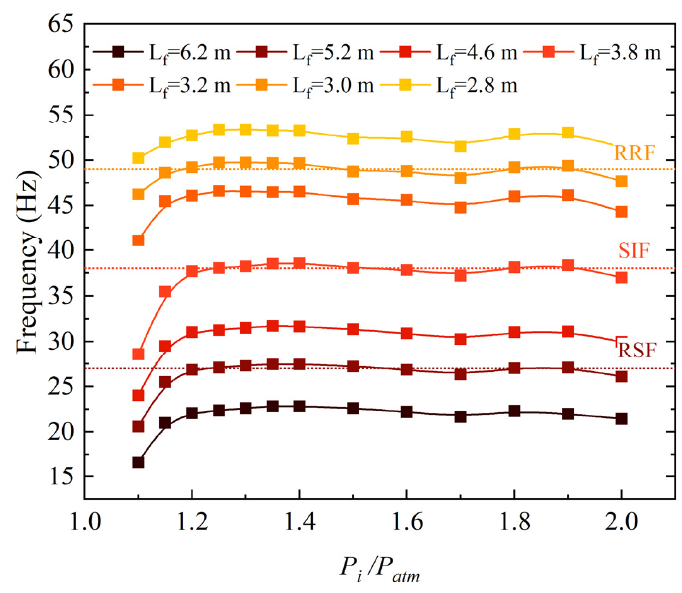
Figure 7. The oscillator frequency response spectrum.